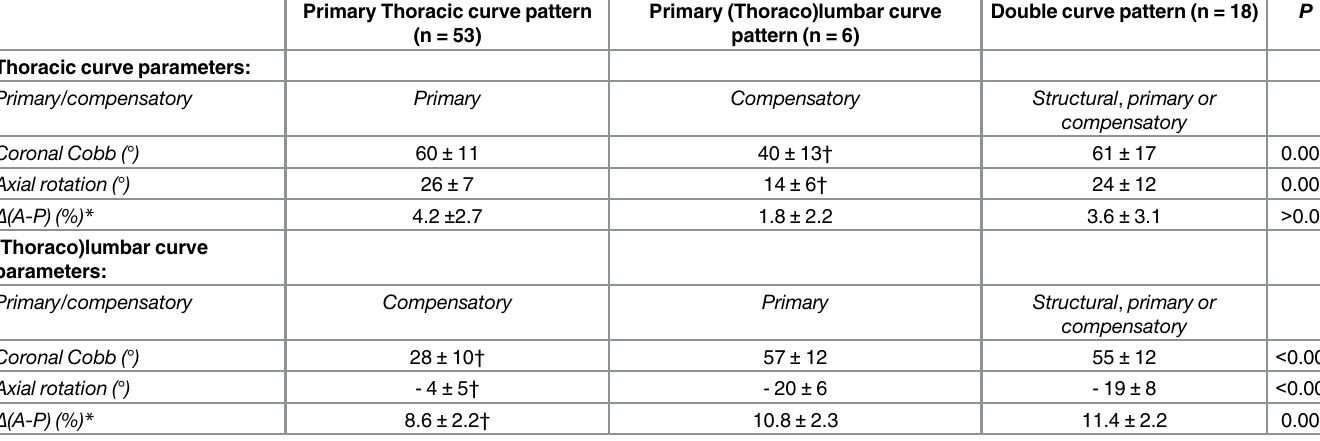
Table 3. Differences in three-dimensional measurements are shown for adolescent idiopathic scoliosis subjects with three different curve types.